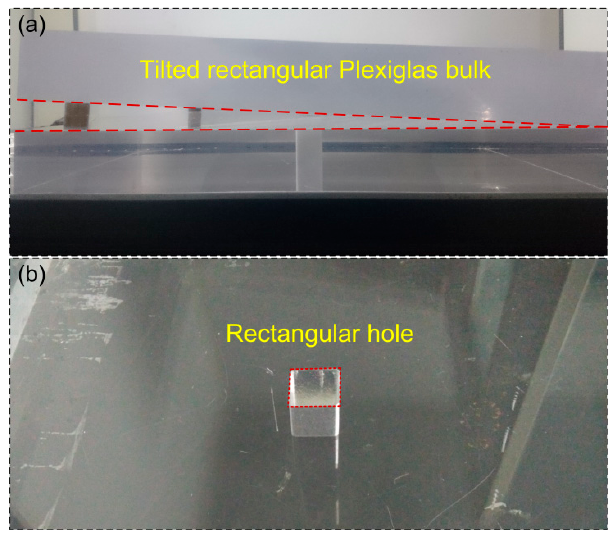
Figure 7. Photographs of two physical models, ( a ) tilt rectangular bulk; ( b ) rectangular hole in a bulk.